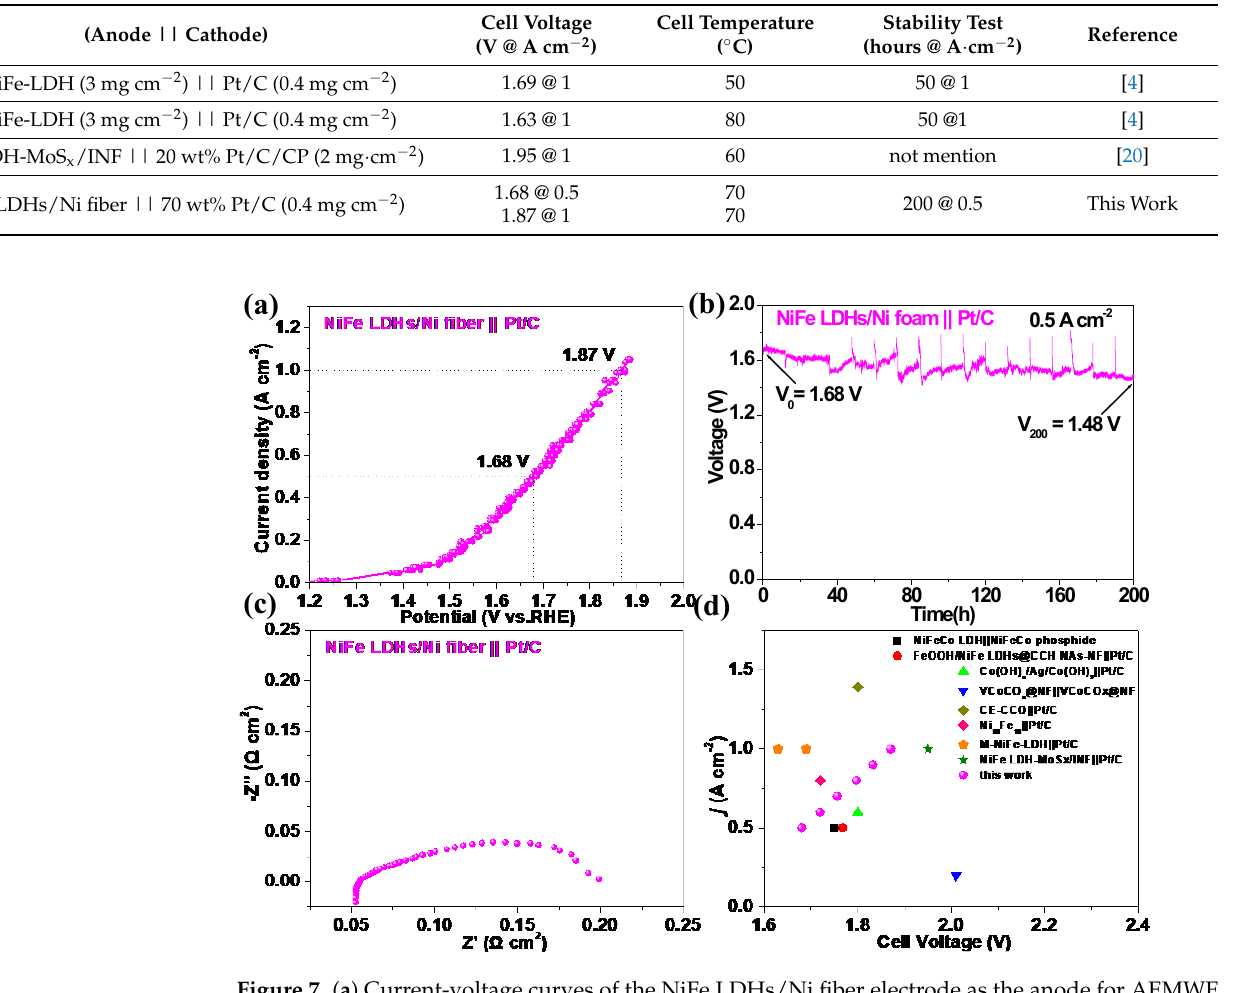
Figure 7. ( a ) Current-voltage curves of the NiFe LDHs/Ni fiber electrode as the anode for AEMWE at 70 °C, ( b ) stability test at 0.5 A cm −2 , ( c ) Nyquist plots were evaluated at 1.7 V, ( d ) comparison of the NiFe LDHs/Ni fiber || Pt/C AEMWE with that recently reported.